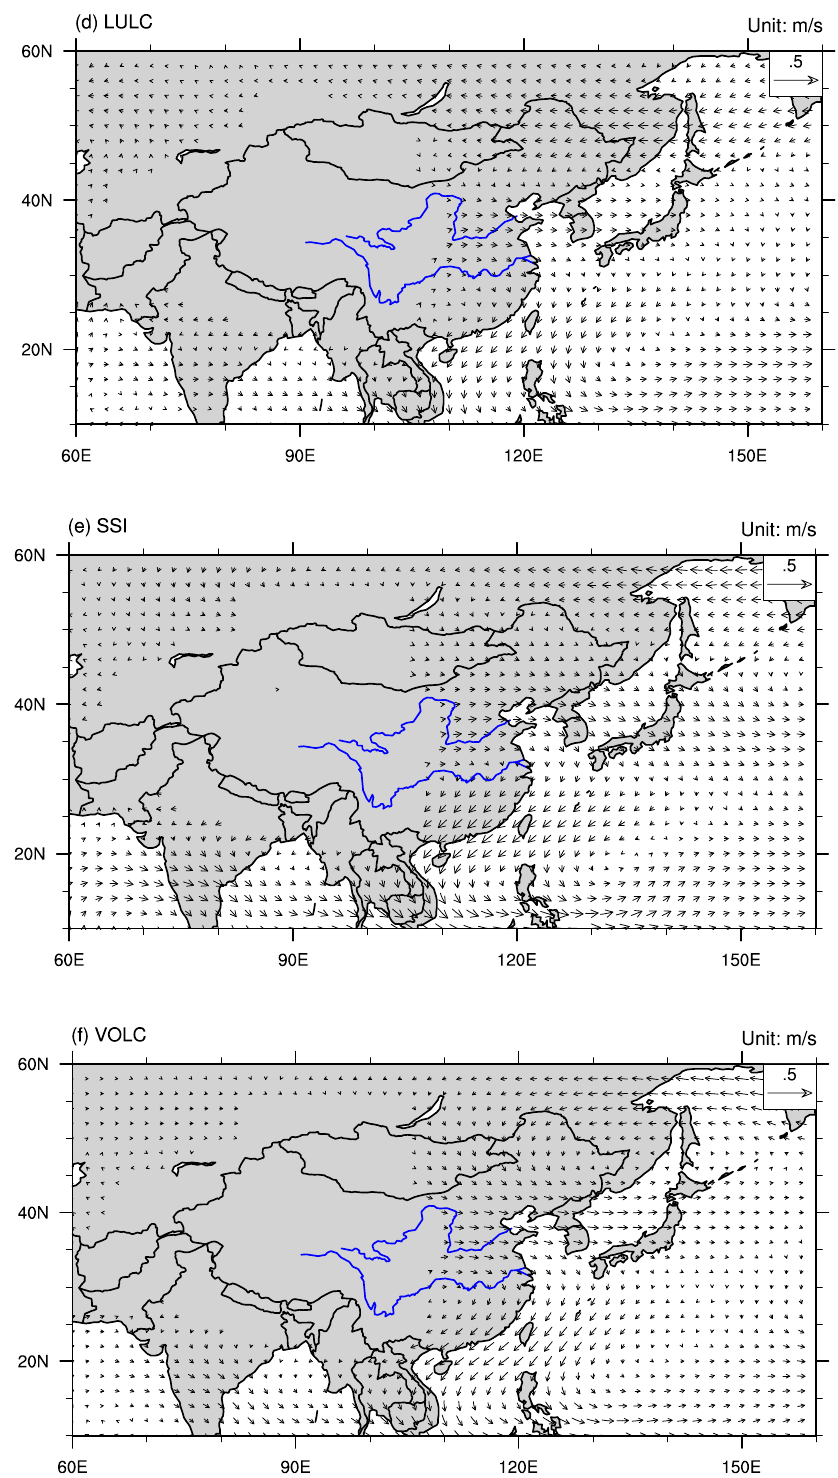
Figure 4. Simulated ensemble-averaged annual wind field anomalies at 850 hPa (unit: m/s) during the megadrought years from the long-term means of the control (CTRL) run ( a ), all-forcing (ALL) runs ( b ), greenhouse gas (GHG) runs ( c ), land use and land cover (LULC) runs ( d ), spectral solar irradiance (SSI) runs ( e ), and volcanic eruption (VOLC) runs ( f ).